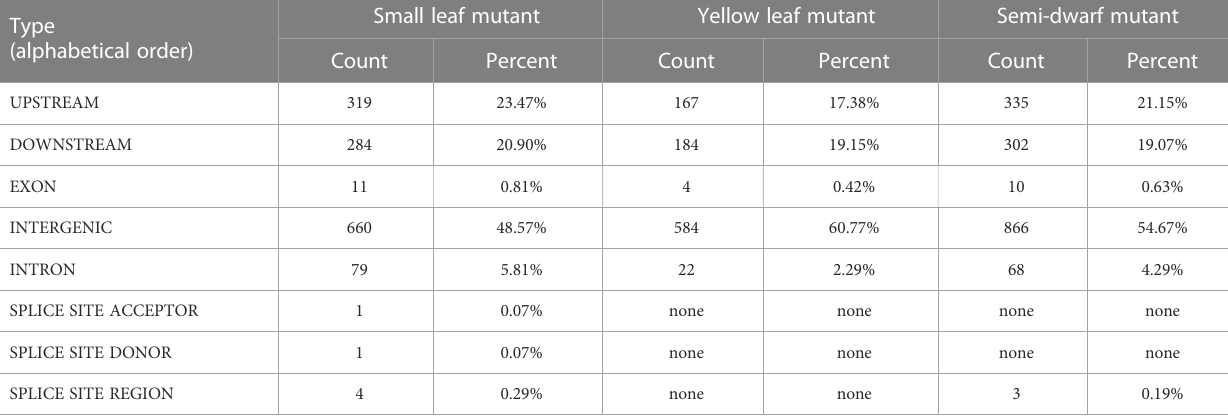
TABLE 3 The locations on the genome of InDels mutations induced by CIB